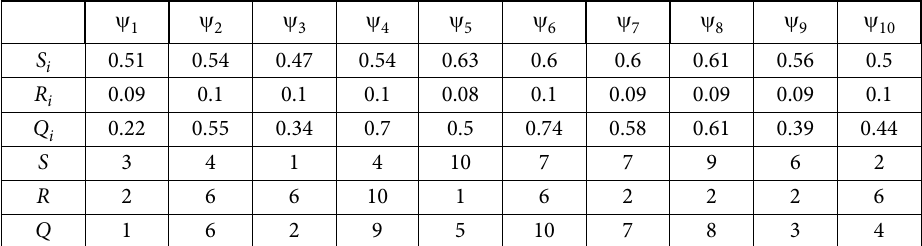
Table 9. The group utility, individual regret and compromise